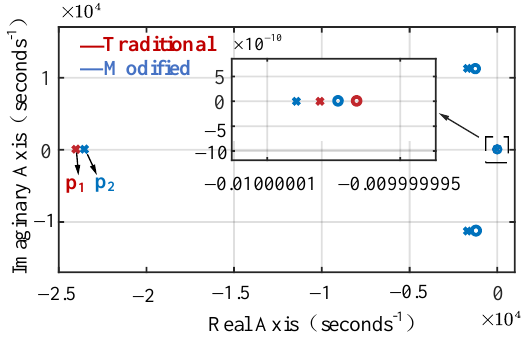
Figure 10. Pole-zero maps of current closed transfer functions for the traditional topology and the modified topology. Table 3. Operating parameters of main circuit used in experiments.